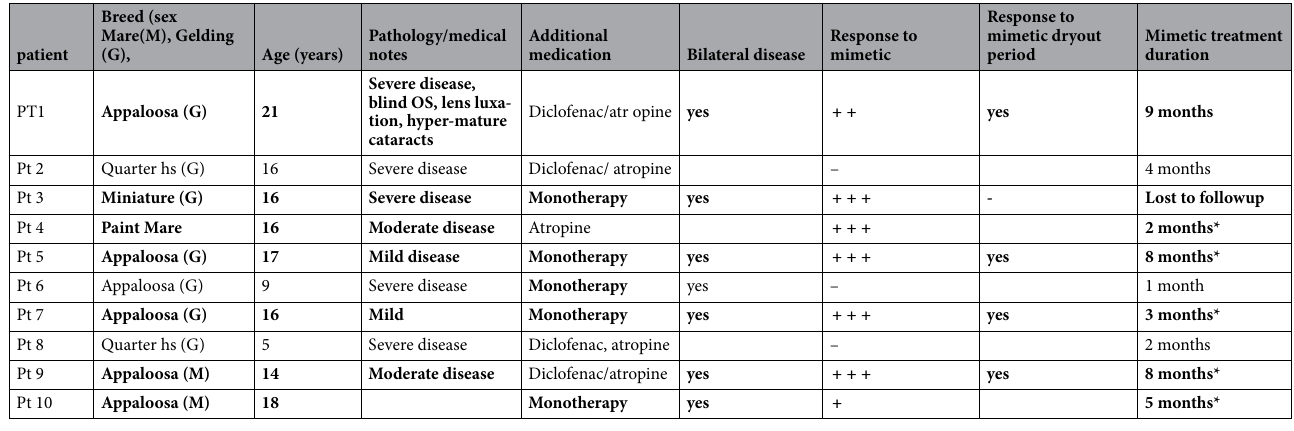
Table 1. Horses used in